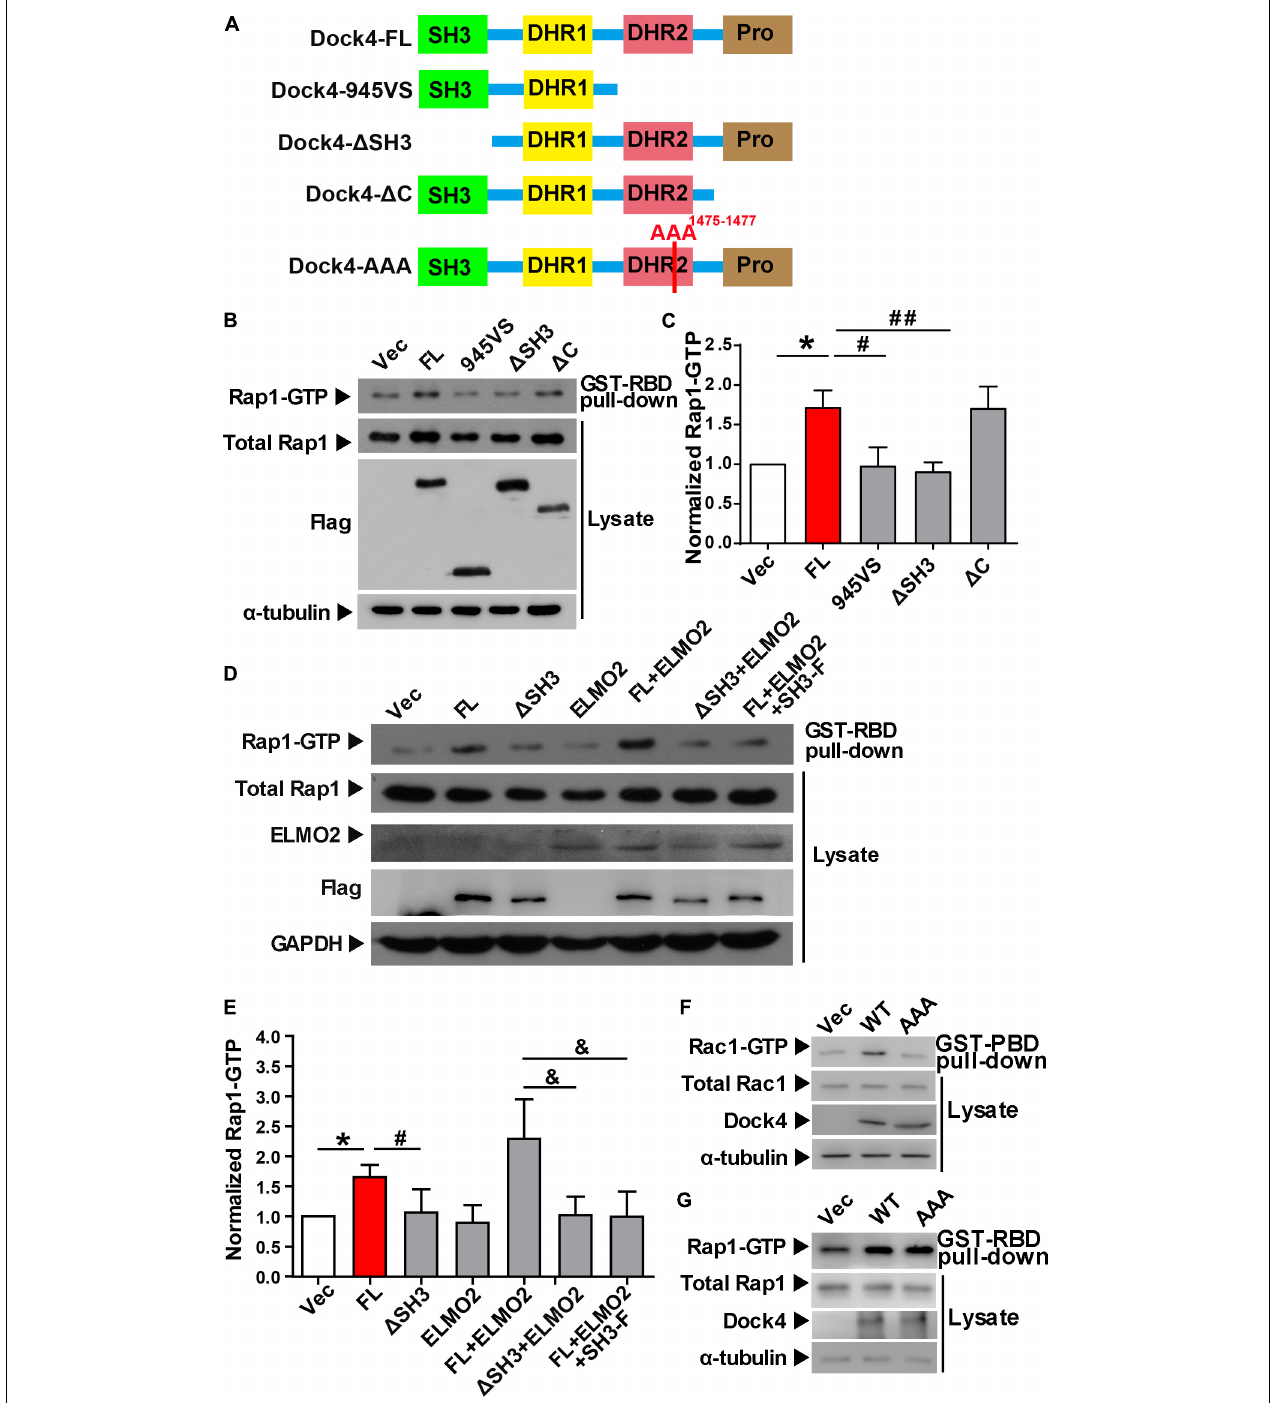
FIGURE 3 | The SH3 domain and DHR2 domain are important for Dock4-regulated Rap1 activation. (A) Domain illustrations of Dock4 and its mutants. (B) Rap1 activation was analyzed after Dock4-FL and various deletion mutants were transfected in HEK293T cells. (C) Rap1-GTP levels were quantified and normalized to total Rap1 expression. Data are shown as mean ± SEM from three independent experiments. ∗ P < 0.05, # P < 0.05, ## P < 0.01, one-way ANOVA. (D) Dock4 activates Rap1 through SH3 domain coupling with ELMO2. ELMO2 and Flag-tagged Dock4-FL, (cid:49) SH3 or SH3-F were co-transfected into HEK293T cells as indicated, and the levels of Rap1-GTP were analyzed. (E) Rap1-GTP levels were quantified and normalized. Data are shown as mean ± SEM from three independent experiments. ∗ P < 0.05, # P < 0.05, & P < 0.05, one-way ANOVA. (F,G) The GEF-dead Dock4-AAA mutant lost Rac1-activating ability, but had intact Rap1-activating ability. Dock4-FL and its AAA mutant were transfected in HEK293T cells. Rac1-GTP (F) or Rap1-GTP (G) levels were examined.